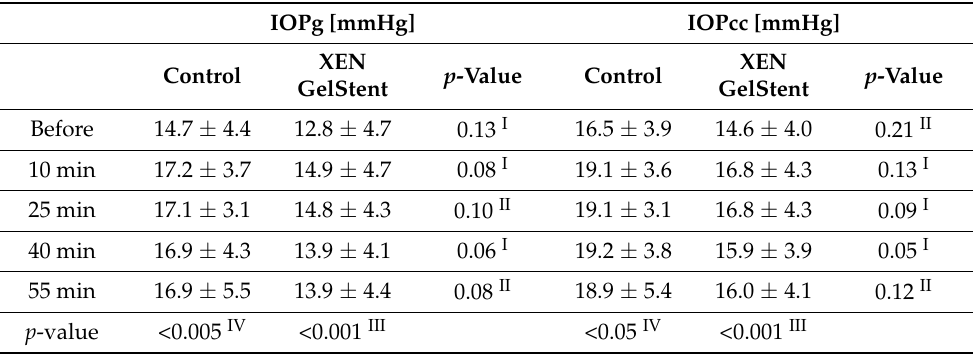
Table 2. The WDT results on the intraocular pressure (IOPcc—corneal-compensated intraocular pressure, IOPg—Goldmann-correlated intraocular pressure) in the control and XEN GelStent groups. IOPg [mmHg] IOPcc [mmHg] XEN XEN p -Value p -Value Control Control GelStent GelStent Before 14.7 ± 4.4 12.8 ± 4.7 0.13 I